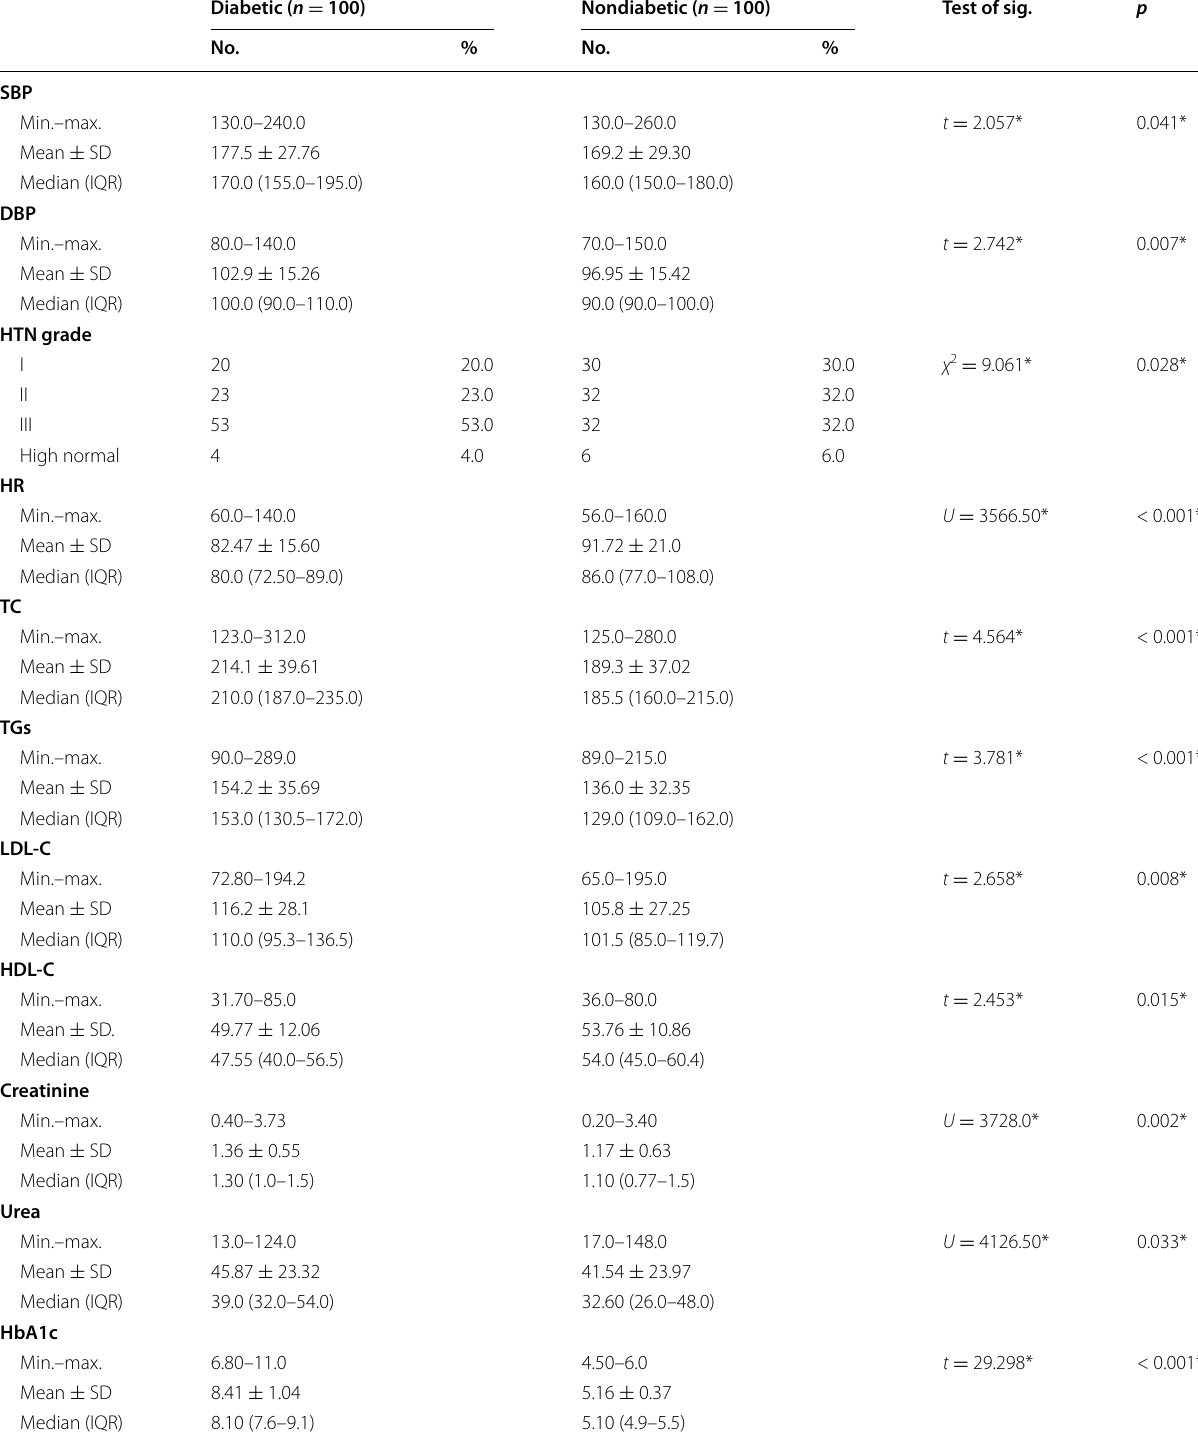
Table 3 Biochemical and clinical parameters at presentation